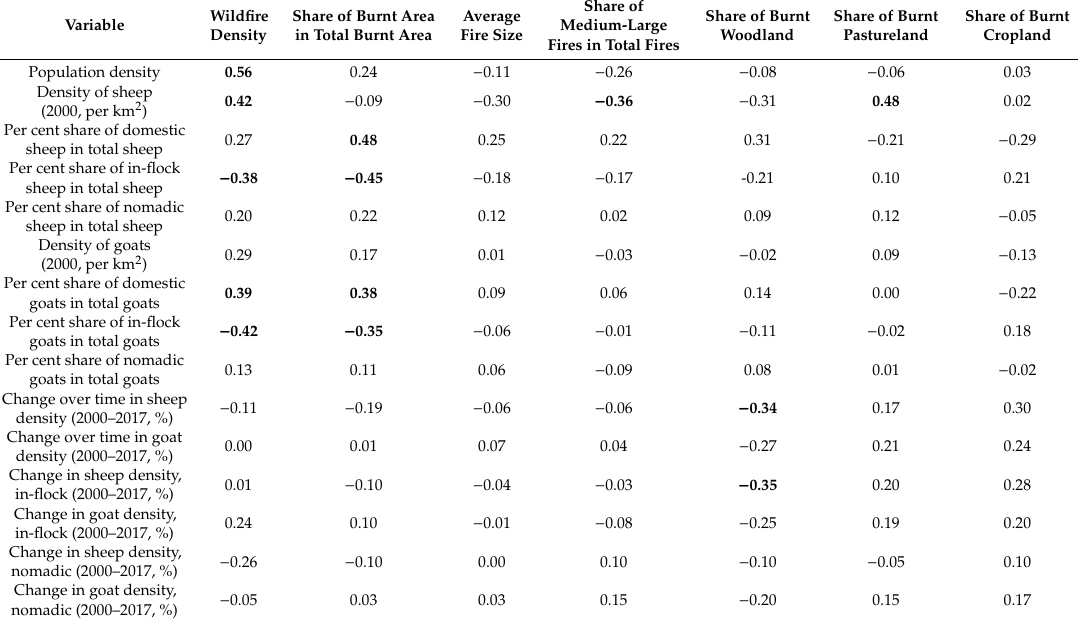
Table 1. Non-parametric Spearman rank correlation coe ffi cients between wildfire characteristics and livestock density at the spatial level of Greek prefectures (bold indicates significance at p < 0.05 after Bonferroni’s correction for multiple comparisons). Source: own elaboration from o ffi cial statistics of the Hellenic Fire Brigade and Hellenic Statistical